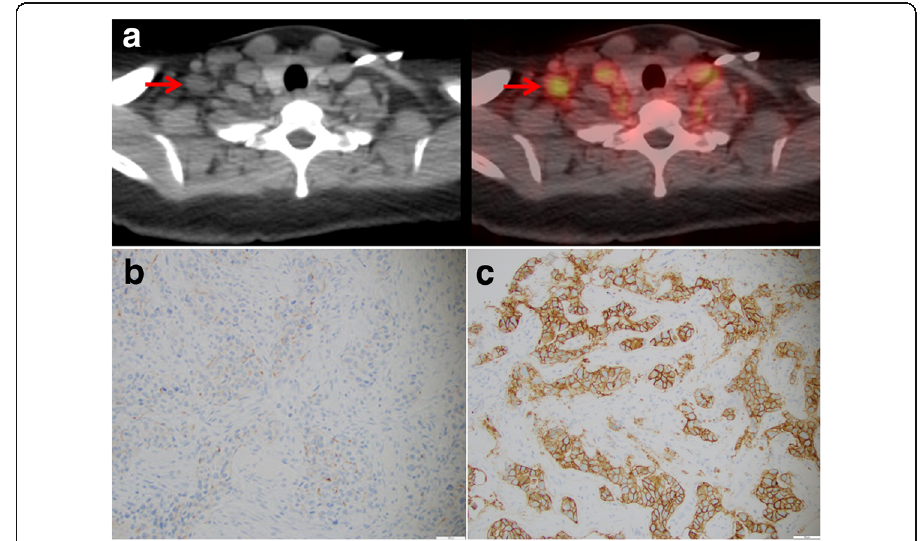
Fig. 3 a 89 Zr-Trastuzumab-PET/CT in a patient with HER2-negative primary breast cancer showing intense tracer uptake in a right supraclavicular lymph node metastasis. b Immunohistochemistry of the primary cancer proved HER2-negativity, while c biopsy and immunohistochemistry of the suspicious lymph node showed markedly HER2-positive metastatic disease. This patient responded to HER2-directed therapy. Adapted and reprinted with permission from Ulaner et al. J Nucl Med 2016;57:1523 –